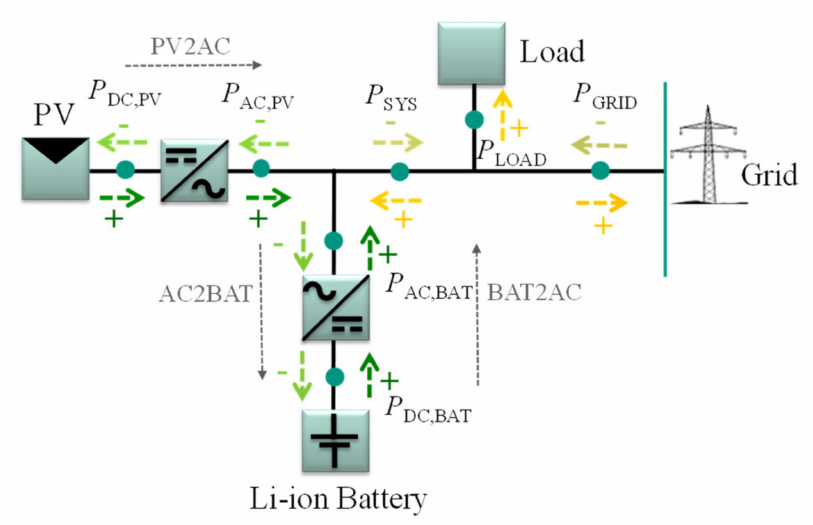
Figure 1. Schematic of an AC-coupled PV home storage system including possible power flows and the corresponding symbols from Munzke et al.